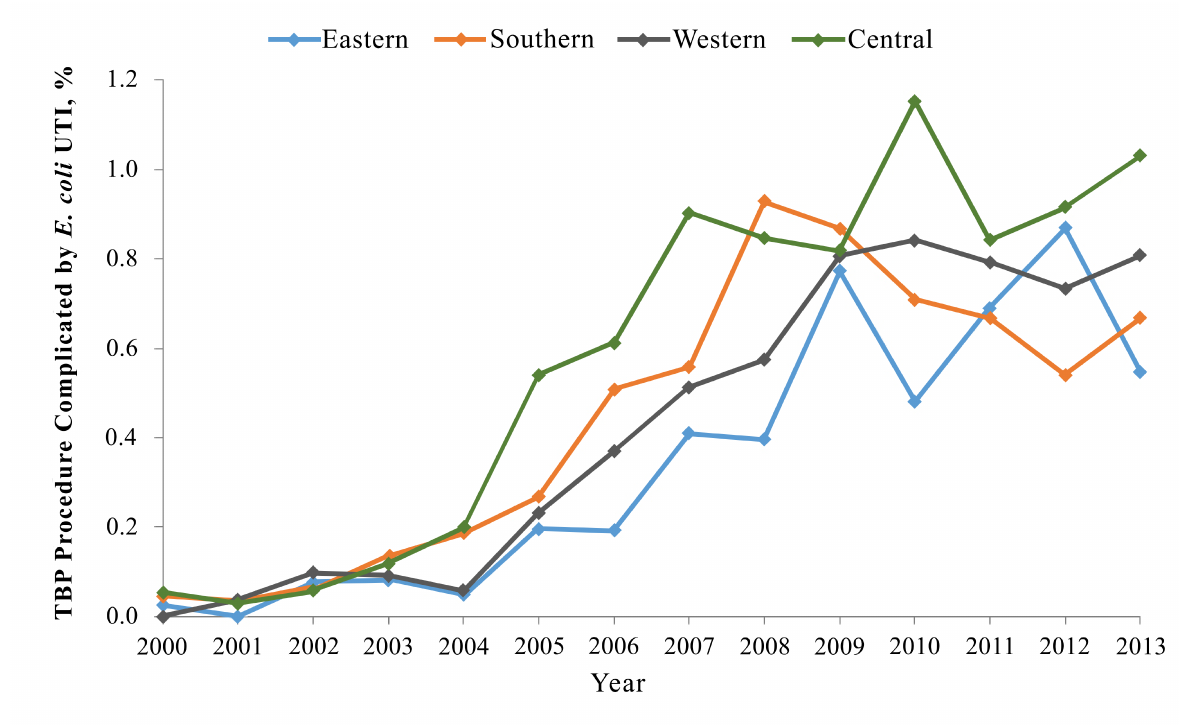
Figure 2. Escherichia coli Urinary Tract Infections Following Transrectal Biopsy of the Prostate, by Geo- graphic